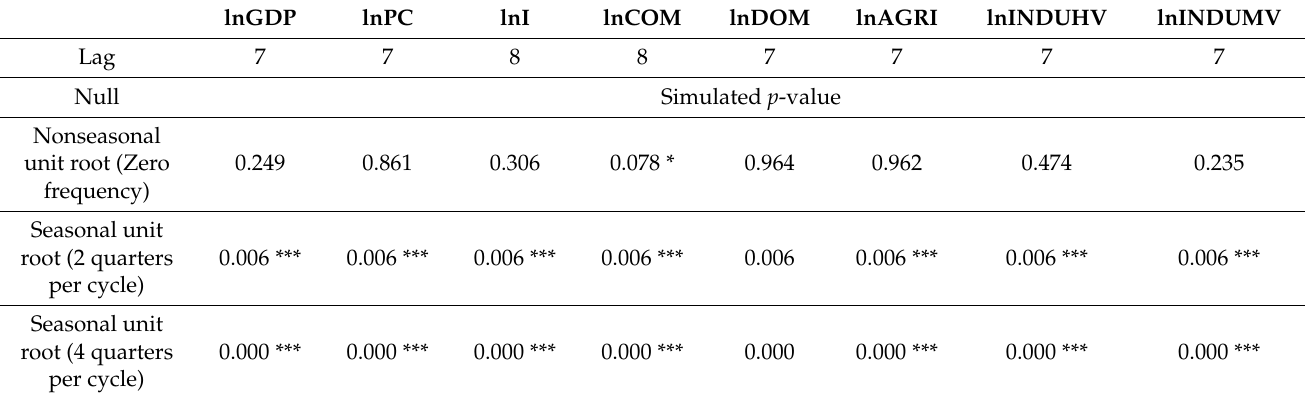
Table 3. HEGY Unit Root Analysis with Constant, Trend and Seasonal